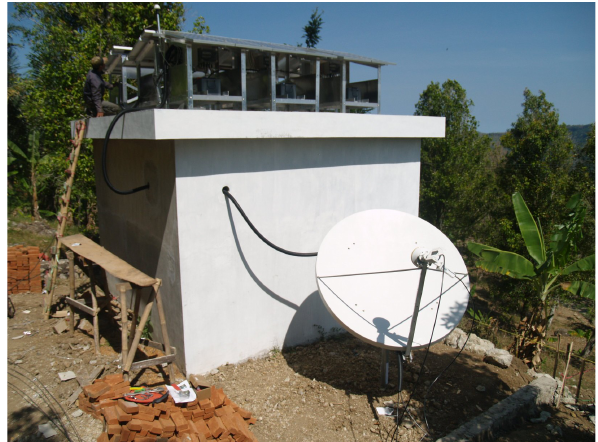
Fig. 10. Remote seismic sensor station with VSAT antenna in Ci- sompet (south of Bandung,